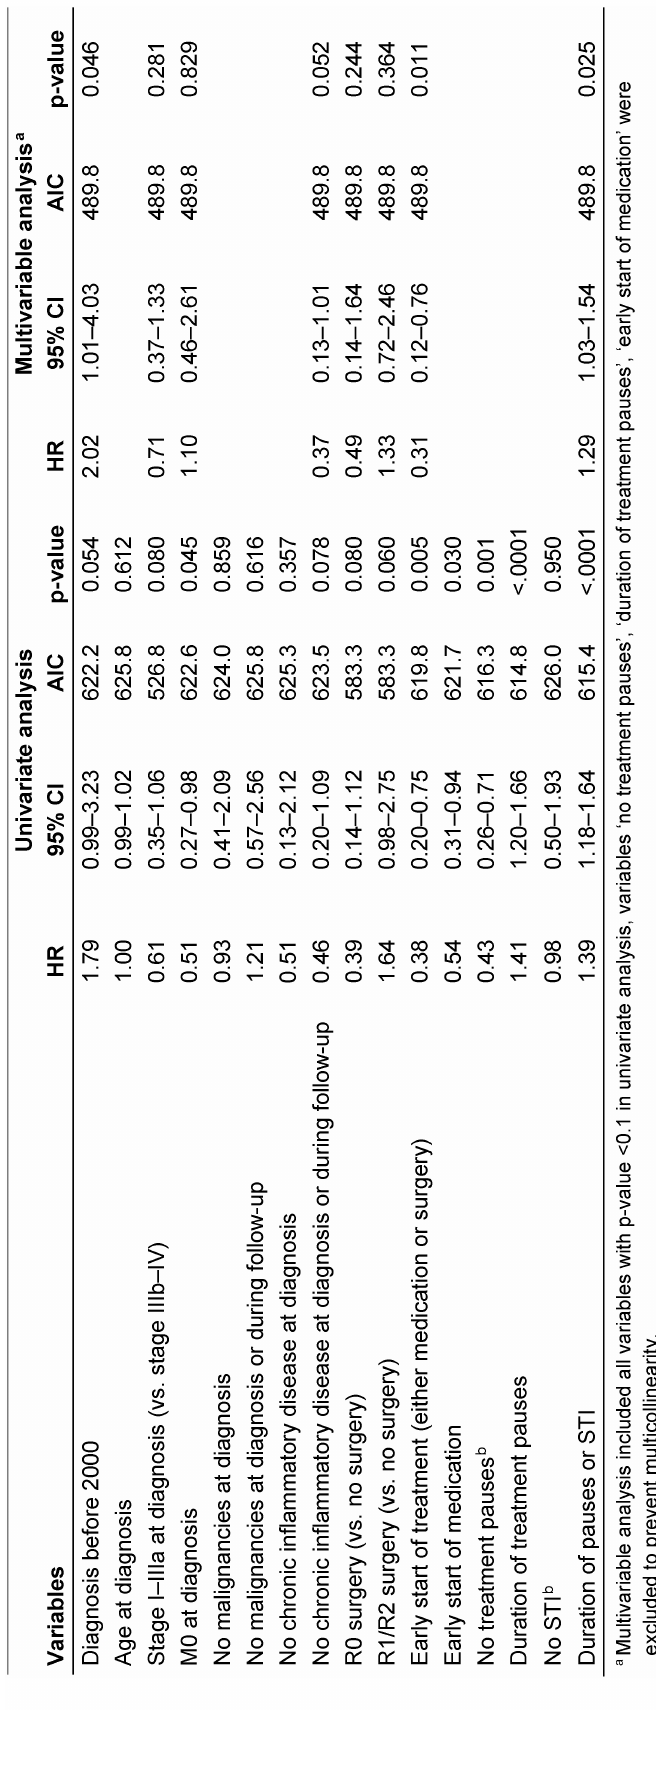
Table 9: Cox proportional hazards regression analysis for covariates of relapse-free